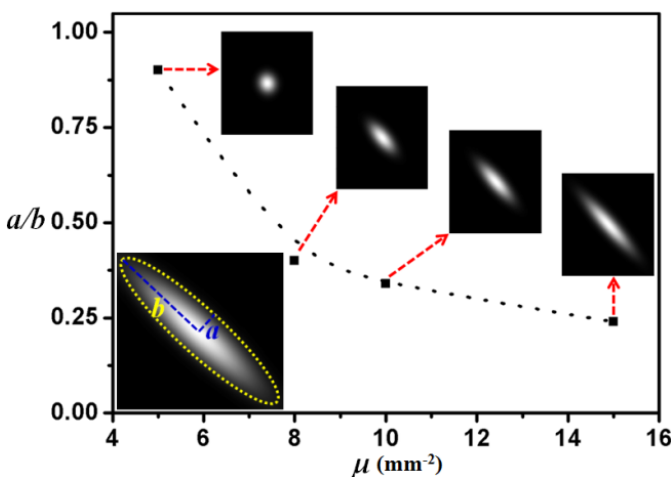
Figure 5. Influence of the cross-phase modulation on the intensity distribution of self-focusing spots. Parameters for calculation are chosen as λ = 633 nm, α = 3, NA = 0.9, f = 3.4 cm, and E 0 = 1.